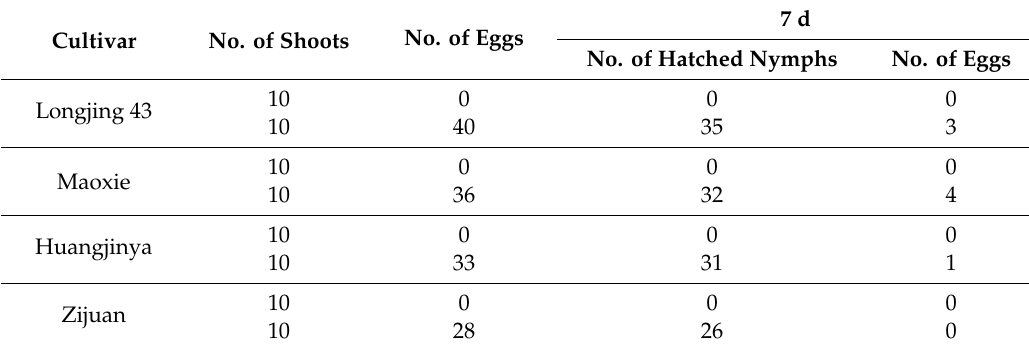
Table 2. Accuracy test of BLDM for the egg detection of E. onukii. 7 d Cultivar No. of Shoots No. of Eggs No. of Hatched Nymphs No. of Eggs 10 0 0 0 Longjing 43